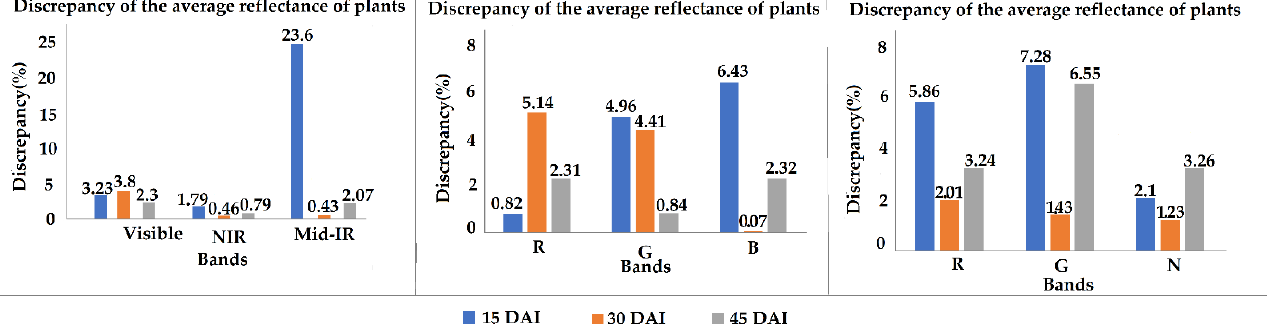
Figure 6. Reflectance discrepancy values between inoculated and non-inoculated seedlings at 15, 30, and, 45 days after inoculation (DAI) of the bands: visible, near infrared (NVI), and medium (IVM) of the simulated reflectance curves; from the red (R), green (G), and blue (B) bands, and from the red (R), green (G), and near infrared (N)